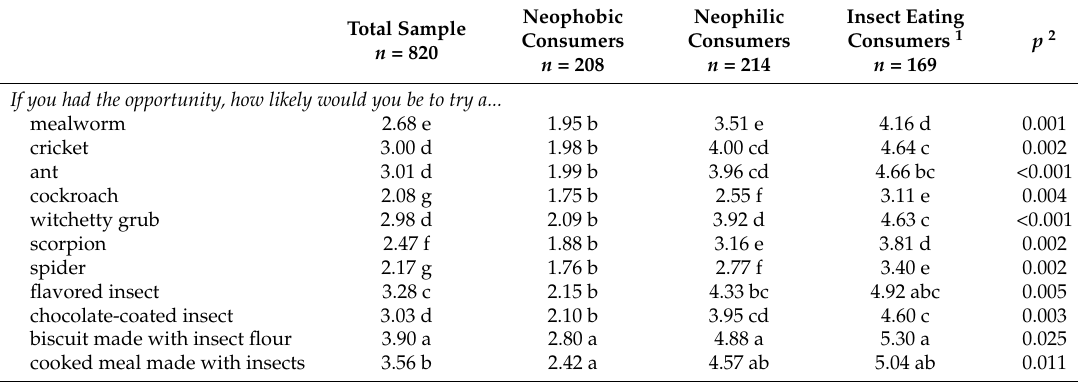
Table 2. Consumer willingness to try edible insects and insect-based products.